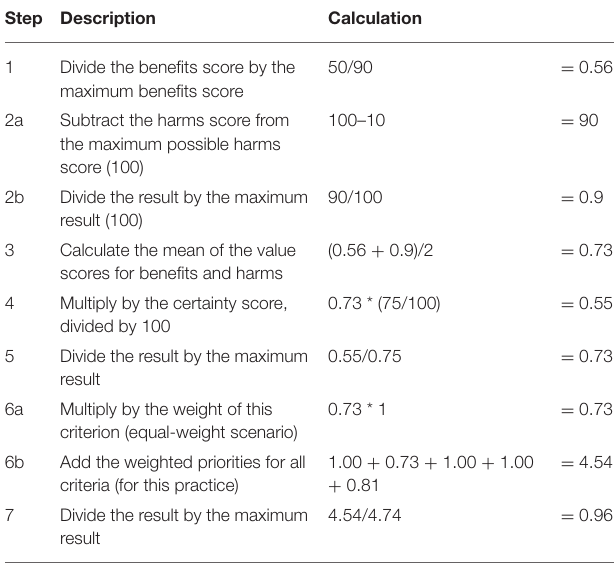
TABLE 2 | The calculation of value scores and priority scores from harms, benefits, and certainty scores. Step Description